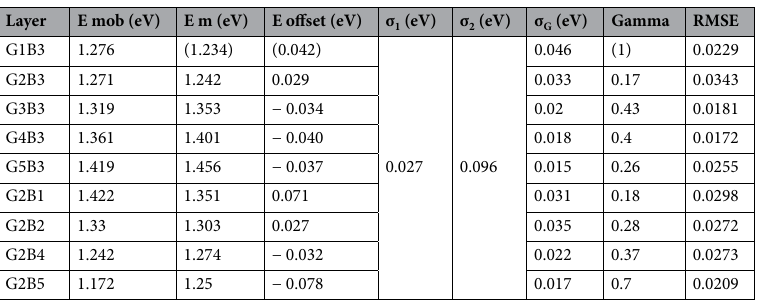
Figure 4a–c show the trends of the exciton broadening, γ (represented as a ratio of the two distributions) and E offset (taken as E mob − E m ) respectively as functions of Bi content. Device G1B3 has been omitted from Fig. 4b and c due to the uncertainty previously mentioned. The exciton broadening is seen to decrease rapidly with increas- ing growth temperature but also decreases with increasing bismuth BEP, indicating it is not solely dependent on the bismuth content of the layer. In Fig. 4a layers G5B3 and G4B3 are seen to have significantly lower exciton broadening values than G2B1 and G2B2 to fit their narrower PL spectra despite having similar Bi contents. This is in agreement with the findings in 26 where an increase in growth temperature resulted in a reduction in FWHM for all layers. G1B3 displayed the largest exciton broadening of 46 meV which is believed to be caused by the low growth temperature. In Fig. 4b the LDOS ratio values all lie between 0.5 and 5 but show no clear trend although there appears to be a weak negative correlation with Bi content. E offset in Fig. 4c broadly follows a similar trend to the exciton broadening except the three highest growth temperatures which have similar values.